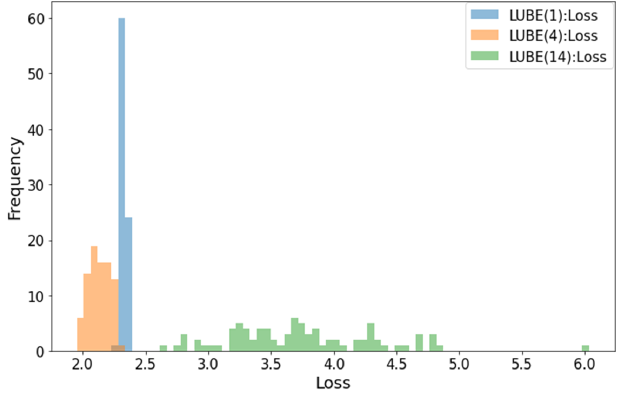
Figure 6. Histograms of 2-week average Loss for LUBE(1), (4), and (14). Table 3. Statistics of 2-week average Loss.